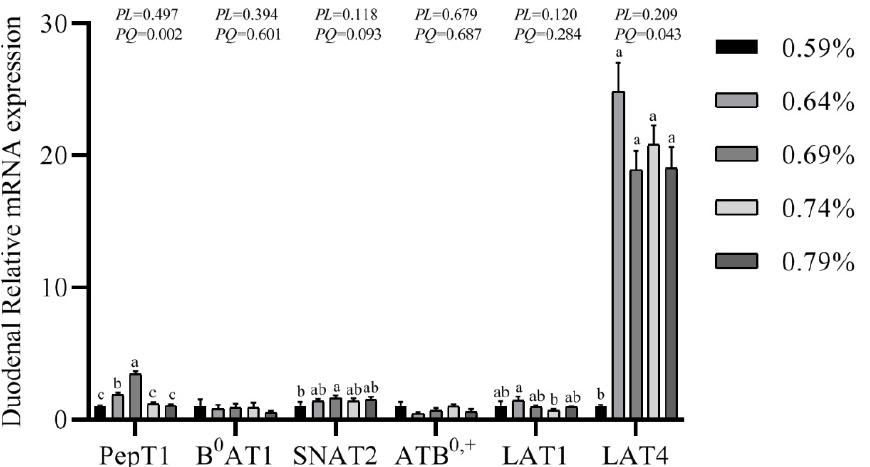
Figure 3. Effects of dietary valine levels on mRNA expression levels of PepT1, B 0 AT1, SNAT2, ATB 0,+ , LAT1, and LAT4 in the duodenum of laying hens. Values are represented as the means and SEM (n = 6–8). Means with different superscript letters (a–c) within a column differ significantly ( p < 0.05).